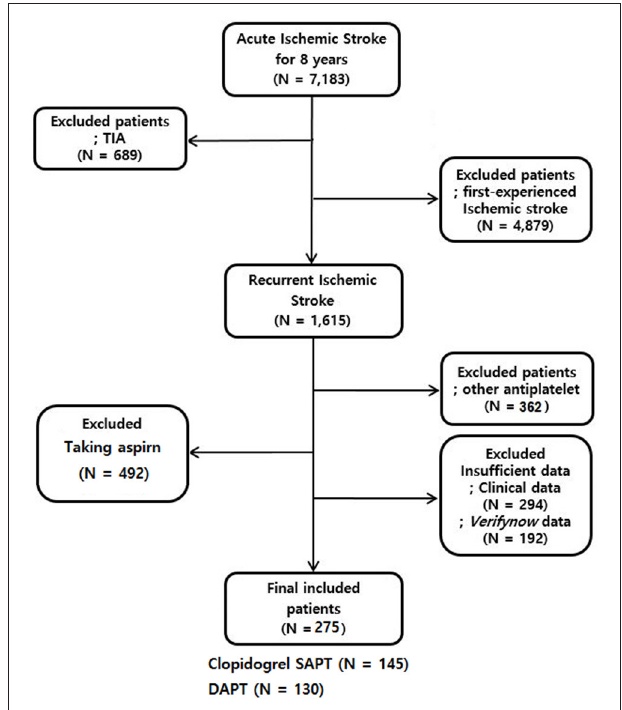
FIGURE 1 | Selection of recurrent ischemic stroke patients who received clopidogrel or DAPT. TIA indicates a transient ischemic attack.